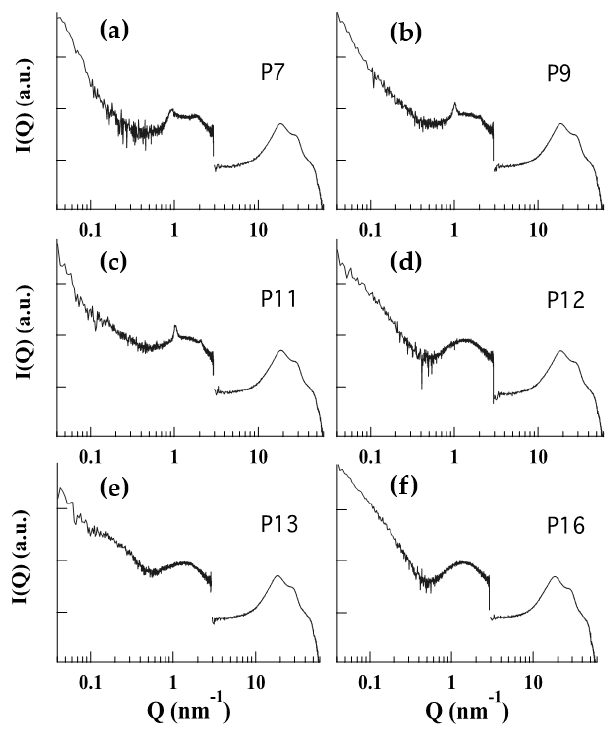
Figure 3. SAXS/WAXS profiles observed at 35 °C. P7 ( a ), P9 ( b ), P11 ( c ), P12 ( d ), P13 ( e ), and P16 ( f ). Table 3. Diffraction parameters of the indicated formulations. Figure Structure Lamellar Repeat Distance